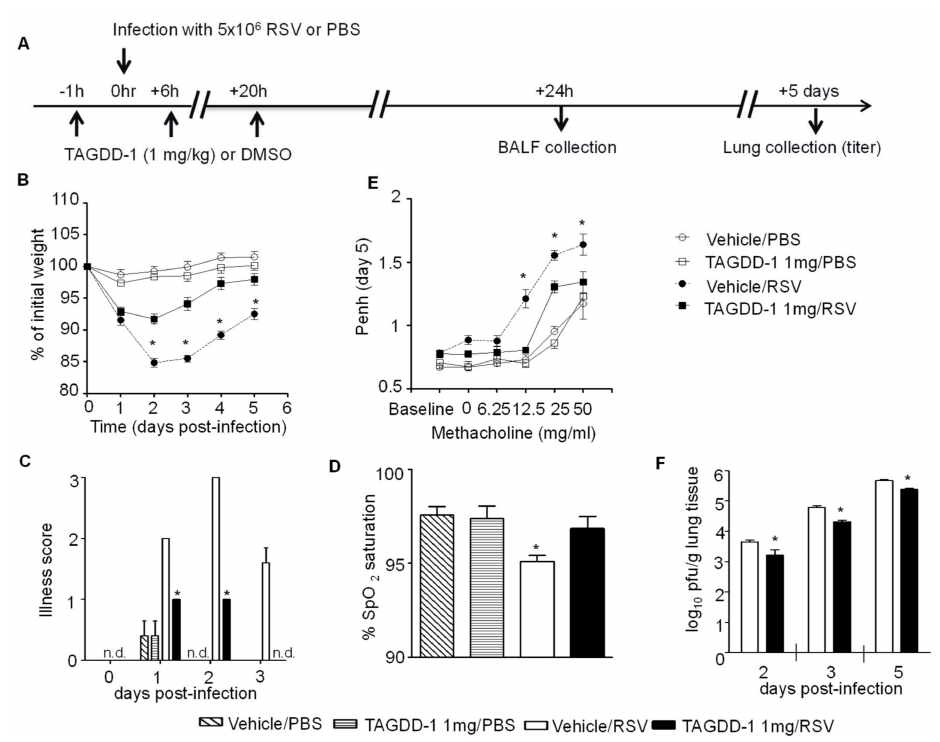
Figure 3. TAGDD-1 treatment attenuates RSV-induced disease and viral titer and ameliorates pulmonary lung function in mice. ( A ) Mice were treated i.n. with different TAGDD-1 (1 mg/kg body weight) or an appropriate volume of vehicle (DMSO) 1 h before, 6 h and 20 h after infection. Mice were inoculated with either RSV or PBS. Mice were monitored daily for changes in body weight ( B ) and disease manifestation ( C ). Body weight ( B ) was calculated based on the original weight before the infection. Black squares—RSV infected TAGDD-1 treated animals; black circles—RSV-infected DMSO (vehicle)-treated animals; open squares—sham PBS-infected TAGDD-1 treated animals; open circles—sham PBS-infected and vehicle (DMSO)-treated animals. Clinical disease score ( C ), calculated on a 0–5 scale where 5 equals death of the animal, was assigned in a blind manner. ( D ) Oxygen saturation levels (SpO 2 ) as determined by pulse-oximetry at day 3 after infection. ( E ) Unrestrained, whole-body plethysmography (Buxco Electronics, Inc., Sharon, CT, USA) was used to measure the Enhanced Pause (Penh) to evaluate airway hyperresponsiveness (AHR). Baseline and post-methacholine challenge Penh values were determined at day 5 after infection. ( F ) At day 2, 3 and 5 p.i., lungs were excised and viral replication was determined by plaque assay. Data are